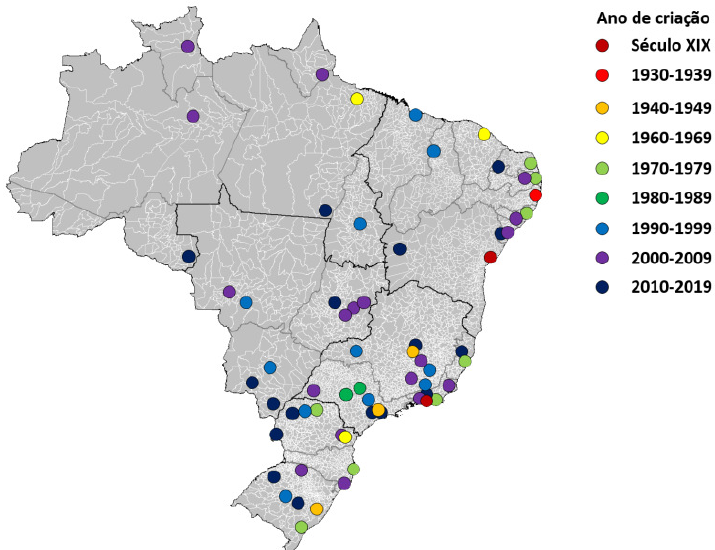
Table 2. Offer of mathematics, civil engineering, and architecture and urbanism in Brazil in 2019.